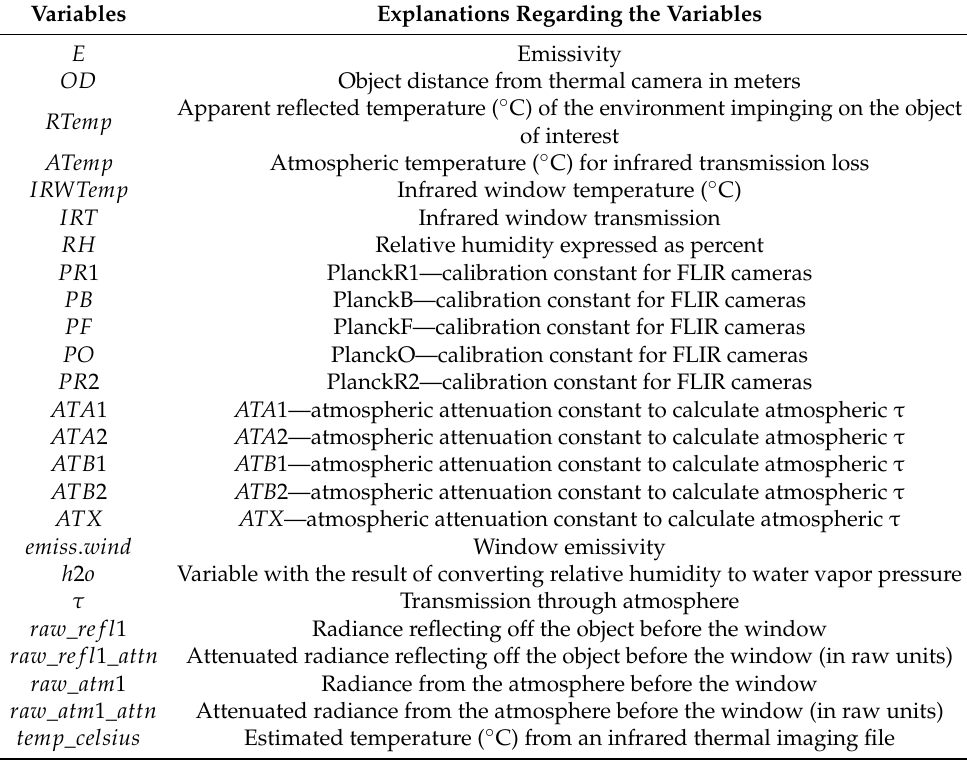
Table A2. Input arguments and intermediary